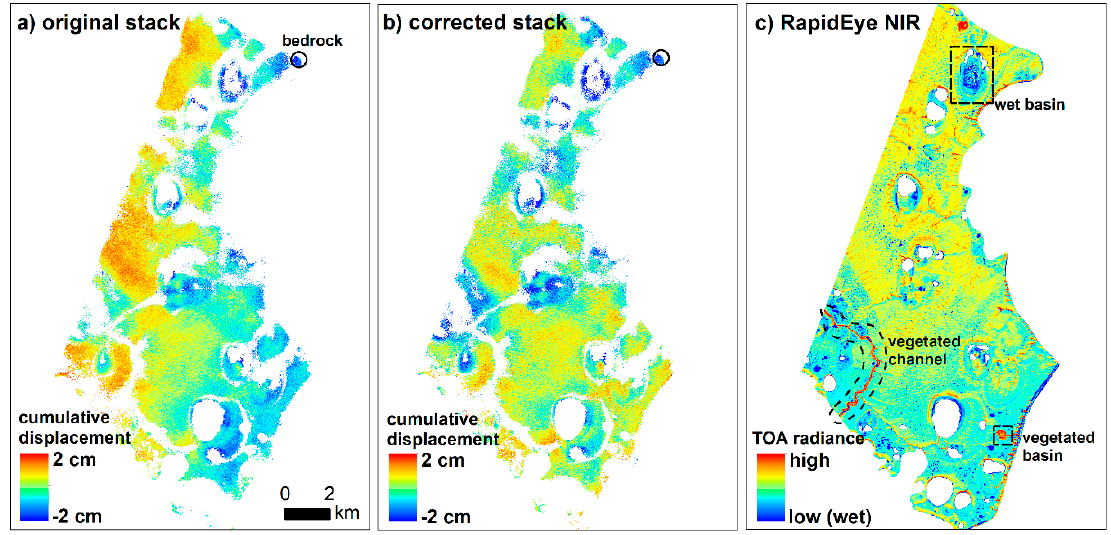
Figure 3. ( a ) Georeferenced sum of eight single displacement maps (cumulative displacement map) with an apparent south-east to north-west linear trend; ( b ) Cumulative displacement map with removed linear trend. Enlarged displacement map is given in Figure 6; ( c ) RapidEye Near Infra-Red Top-of-Atmosphere radiance, where high values correspond to the abundant vegetation, such as in the basin and the channel, marked with a black dashed line. Low values correspond to the wet areas, such as in the basin on the upper part of the image, marked with a black dashed line.